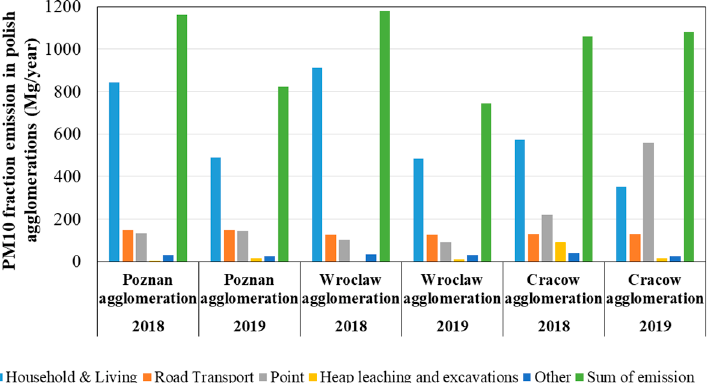
Figure 7. PM10 emission in Polish agglomerations in 2018 and 2019 [19,24,25,33,34,40].